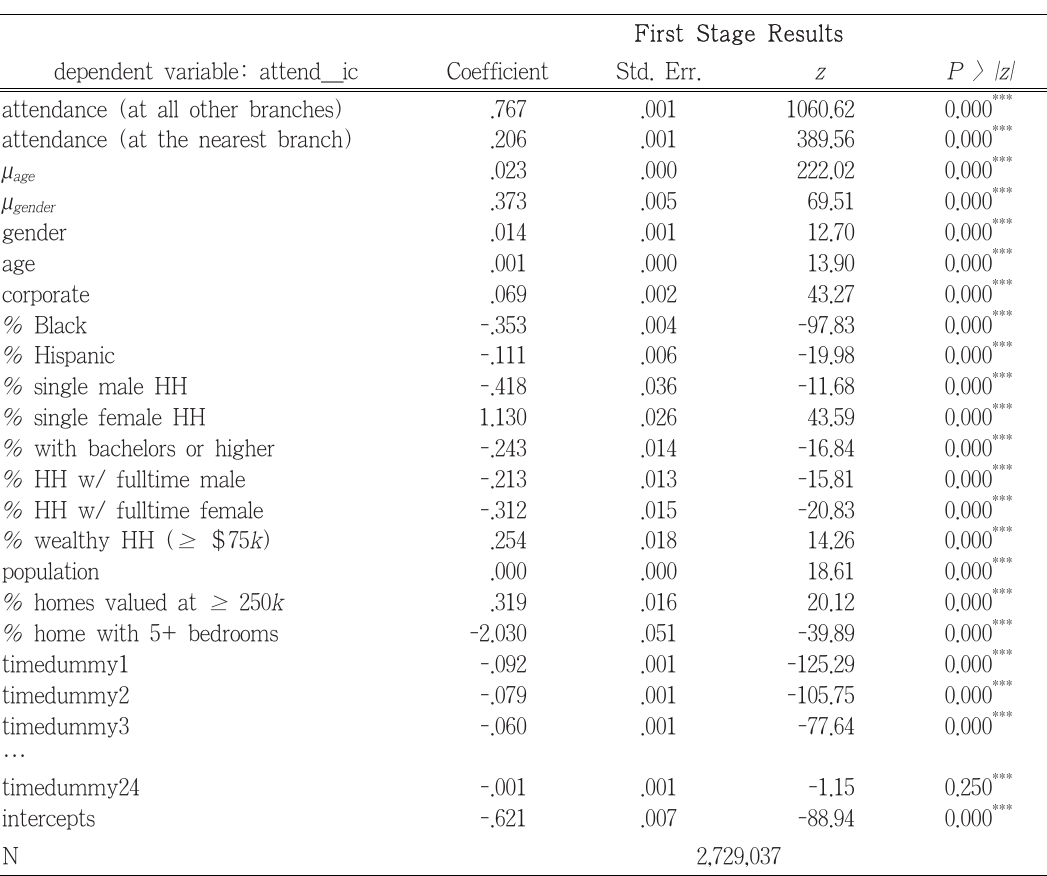
<Table 4> Panel IV models - First Stage Estimation Results